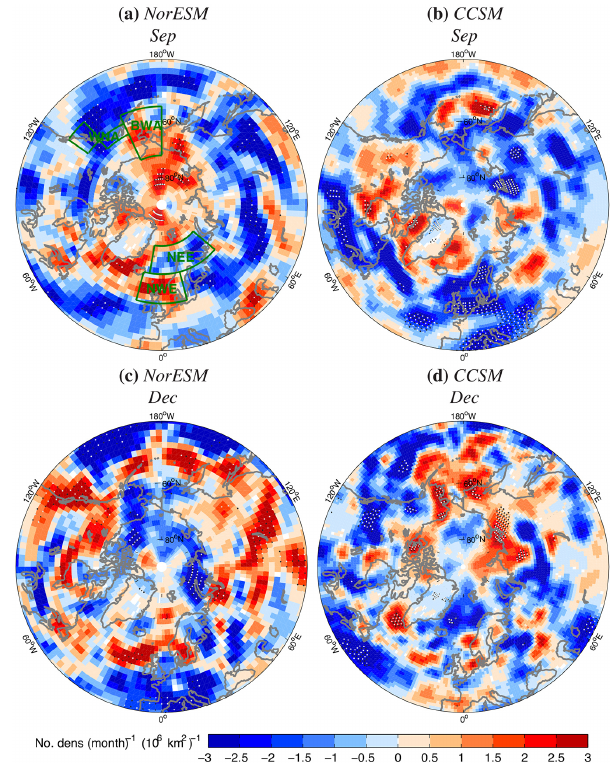
Figure 11. Changes in track density averages for September (up- per row) and December (lower row) 2074–2100 compared to 1979– 2005 following the RCP8.5 scenario in (a, c) NorESM and (b, d) CCSM. Alternating black and white dots mark regions where p < 0 . 05 based on 2000 samples. Green boxes in panel (a) show the four regions in Table